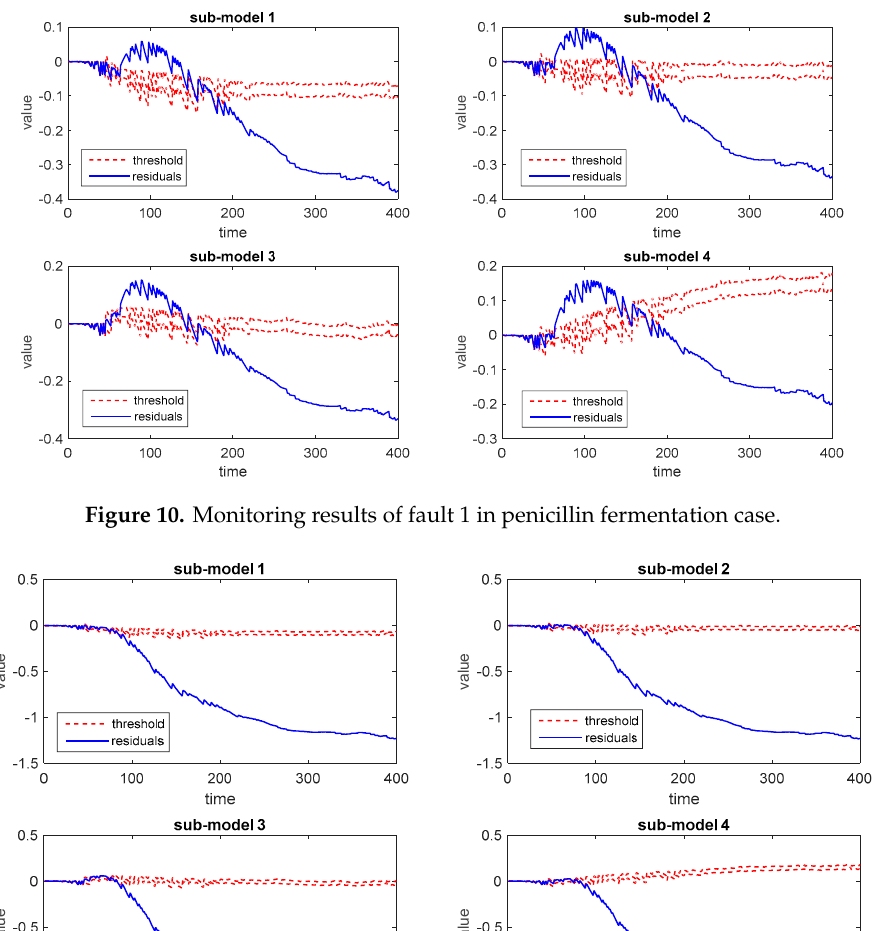
Figure 9. Monitoring results of the normal batch in penicillin fermentation case.